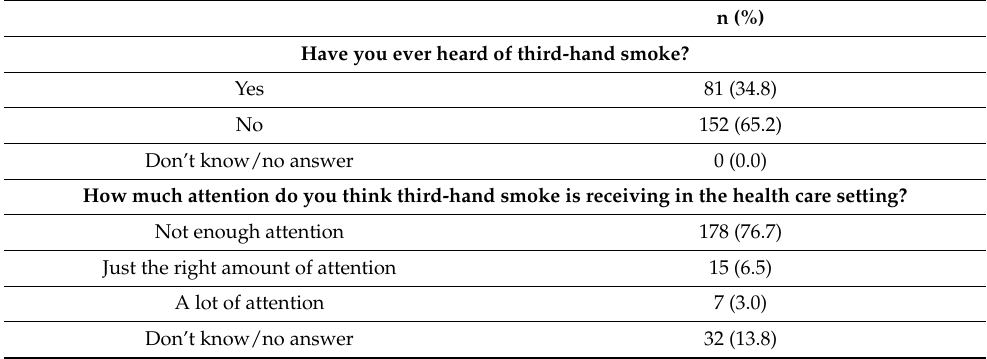
Table 2. Response to questions on prior knowledge and opinions about third hand